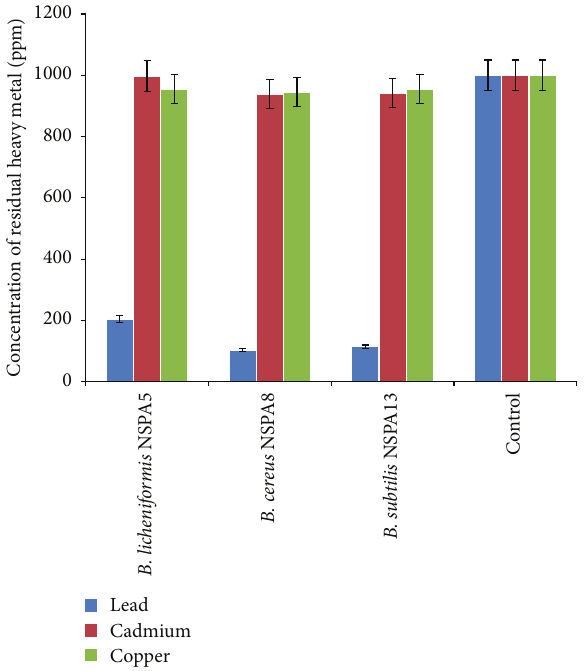
Figure 3: Metal concentration in the medium determined by ICP- OES after removal of the bacteria.